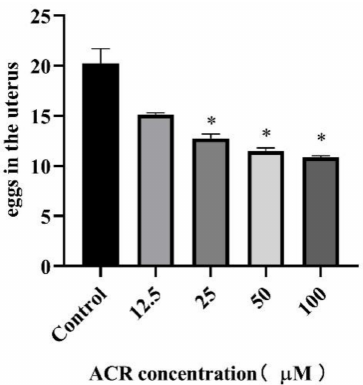
Figure 4. Effect of ACR exposure (12.5, 25, 50, and 100 µ M for 48 h) on eggs in the uterus of C. elegans . Values are means ± SD. * Compared with the control group, p <